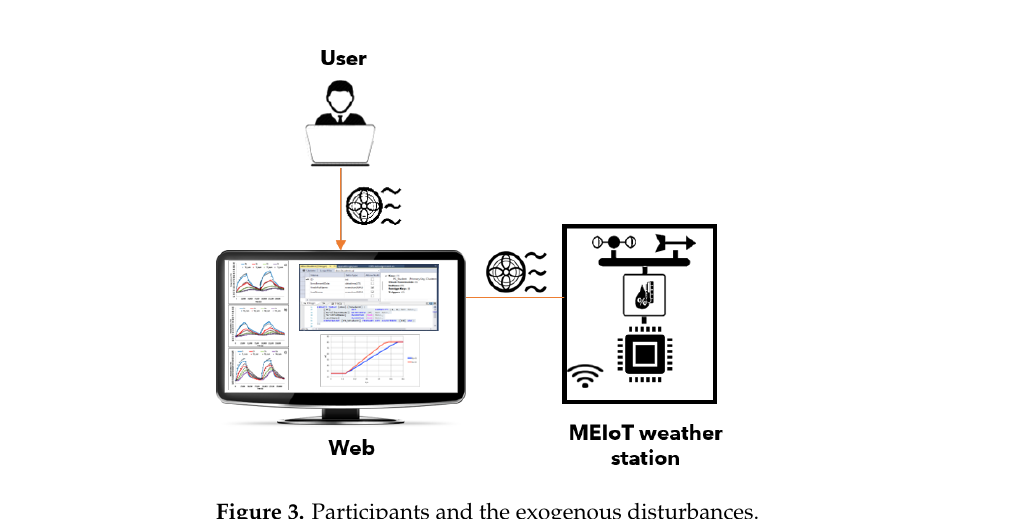
Figure 3. Participants and the exogenous disturbances.